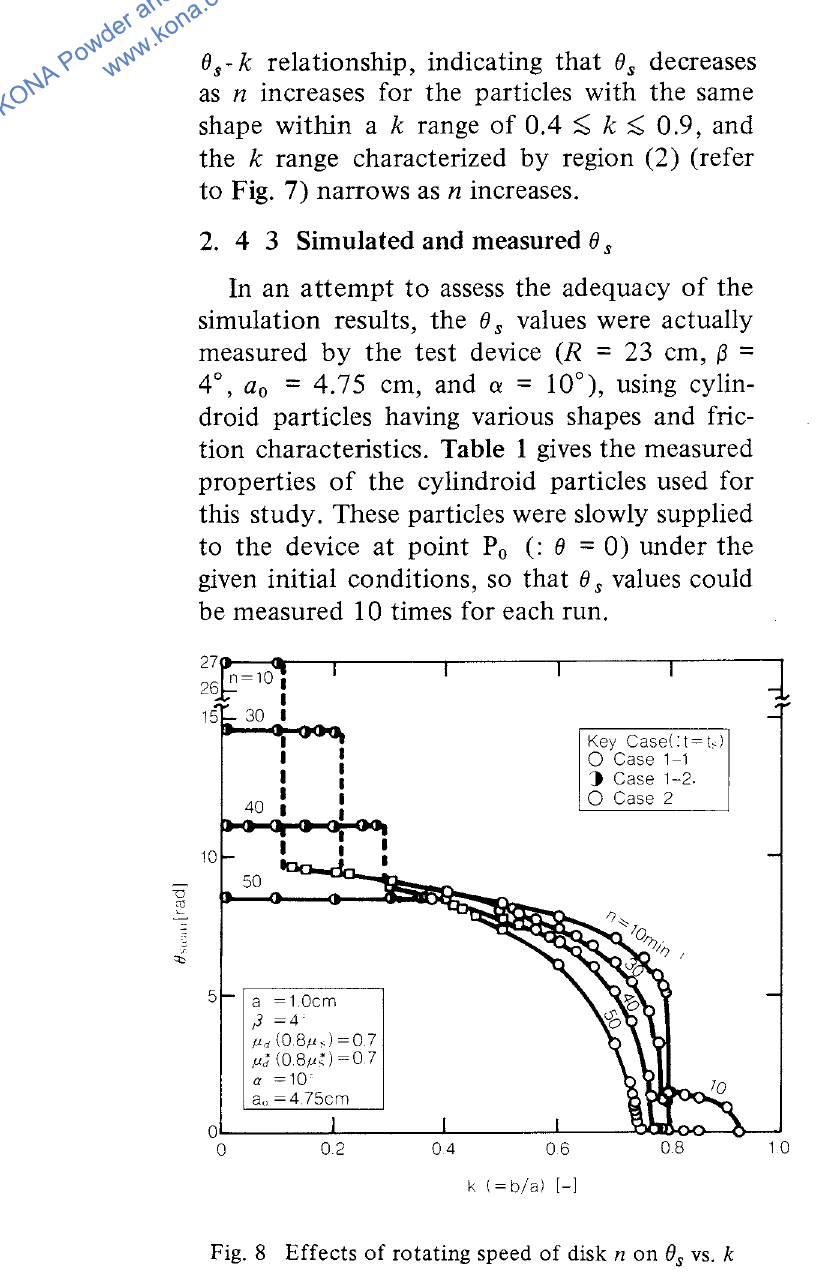
Fig. 8 Effects of rotating speed of disk n on 8